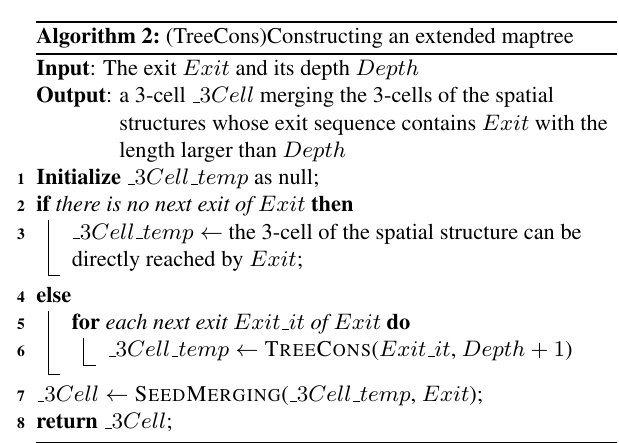
Algorithm 2: (TreeCons)Constructing an extended